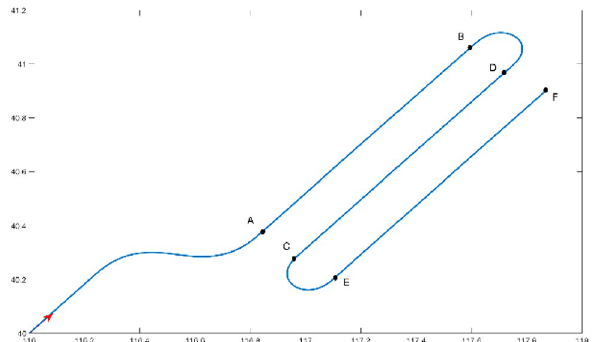
Figure 2. Flight trajectory.